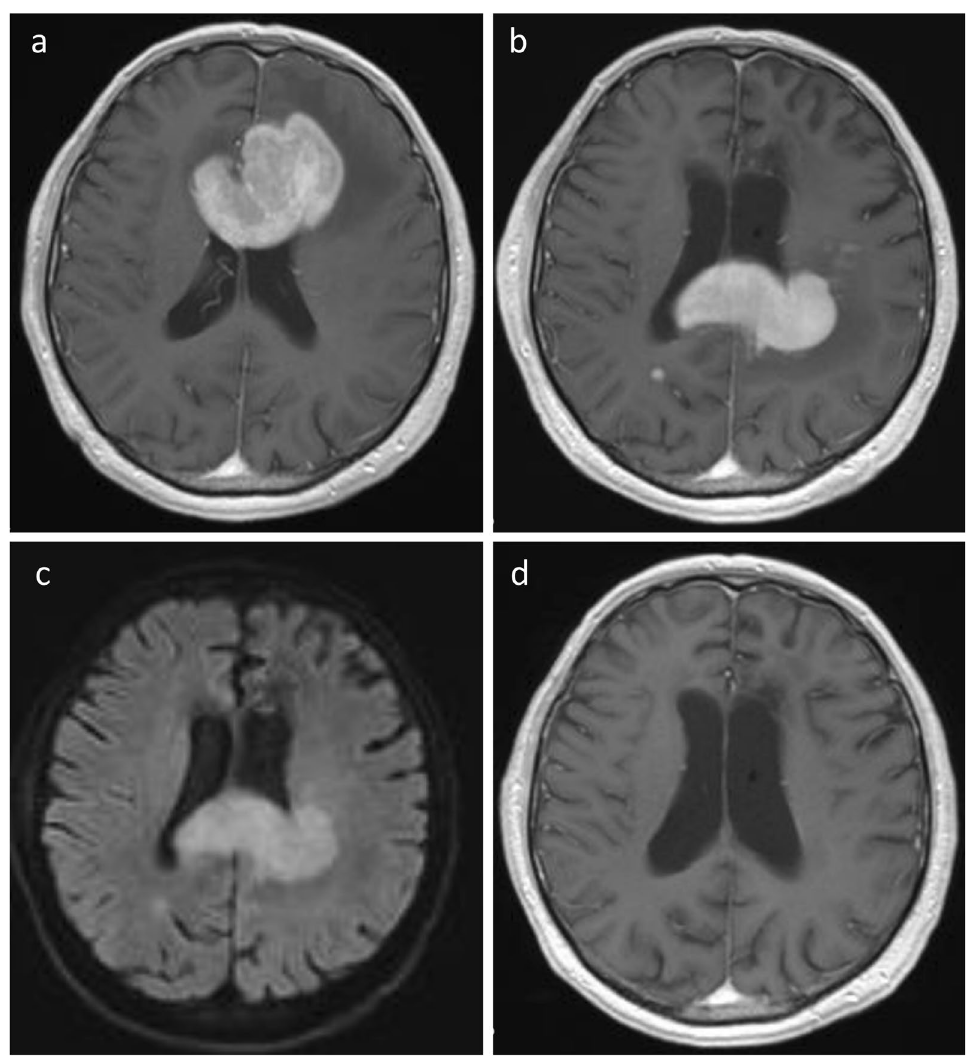
Fig. 1 cMRI imaging of a 63 years old patient at a initial diagnosis (T1 weighted imaging with contrast medium), b at relapse (T1 weighted imaging with contrast medium), c also at relapse (diffusion weighted imaging) and d at remission after HD‑MTX based retreatment plus focal radiotherapy (T1 weighted imaging with contrast